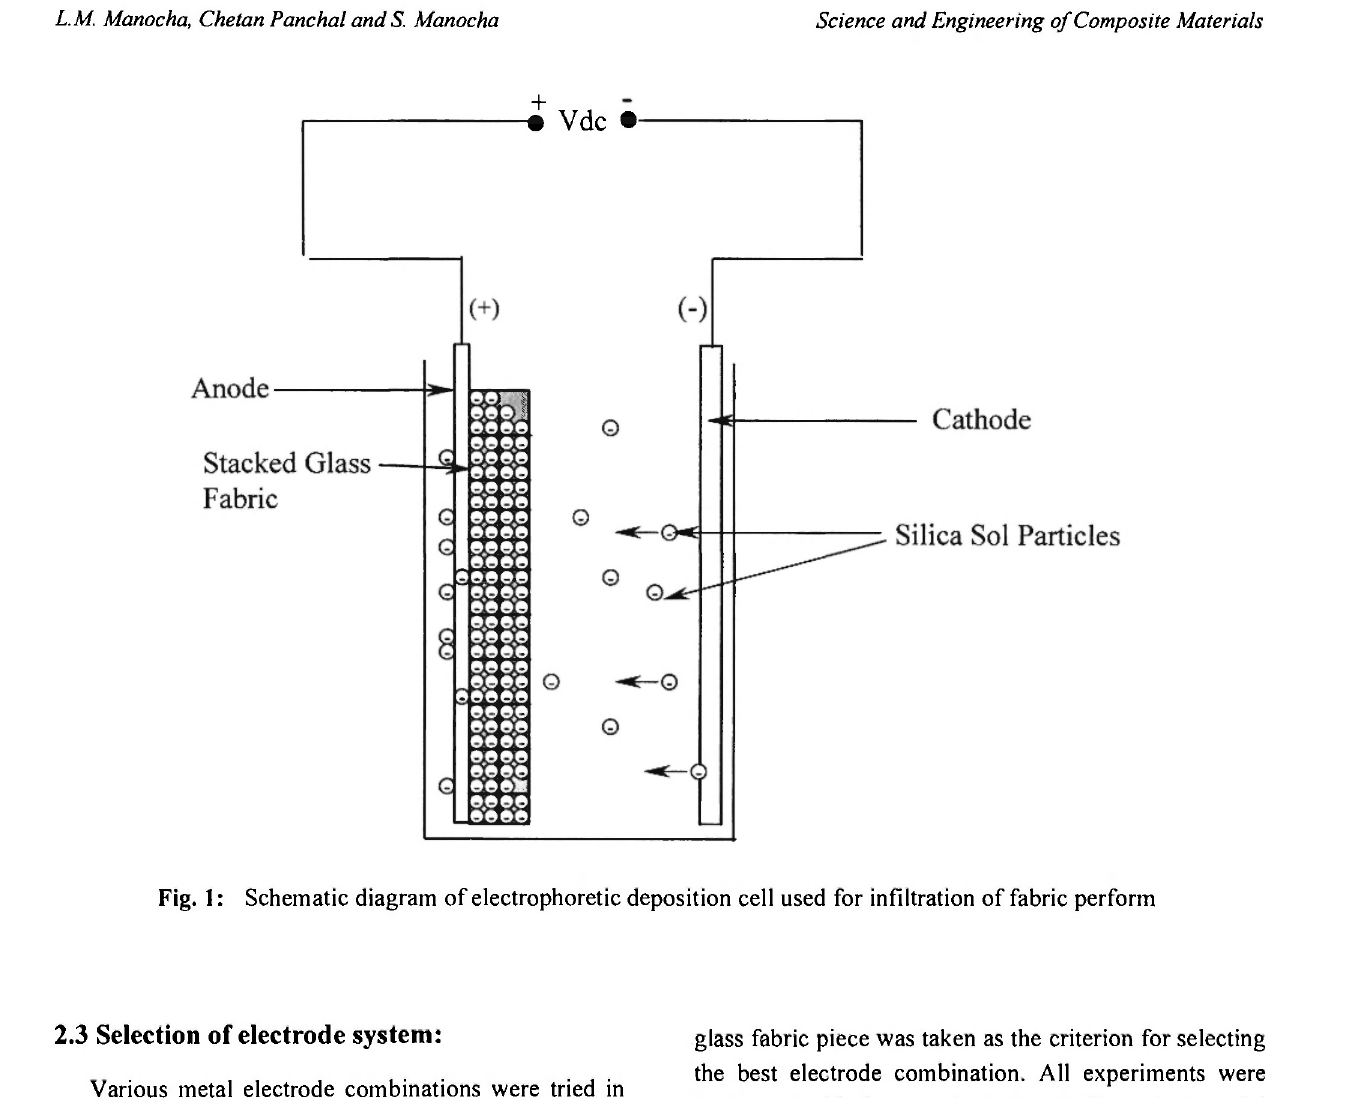
glass fabric piece was taken as the criterion for selecting the best electrode combination. All experiments were performed with the same hydrolyzed silica sol. Potential difference between the electrode was kept at 60 V DC. The results combinations are compiled in Table 2.